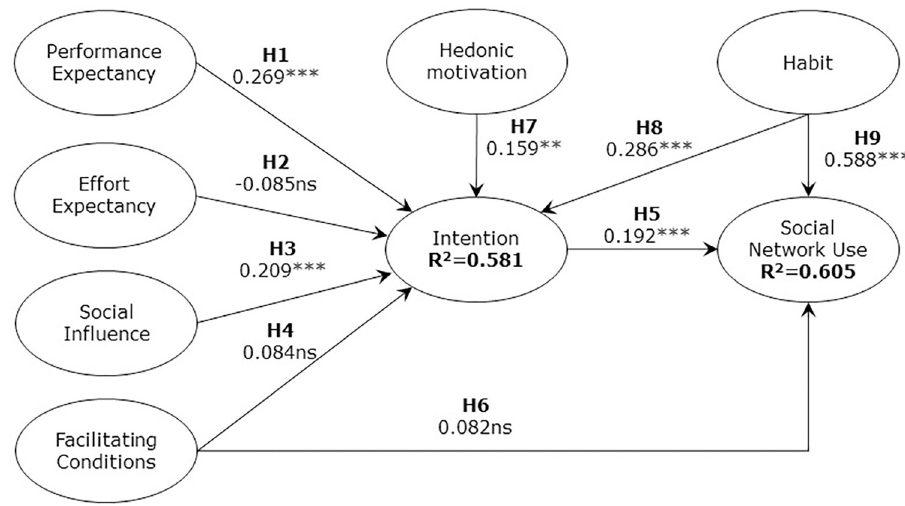
Fig 3. PLS results of the global